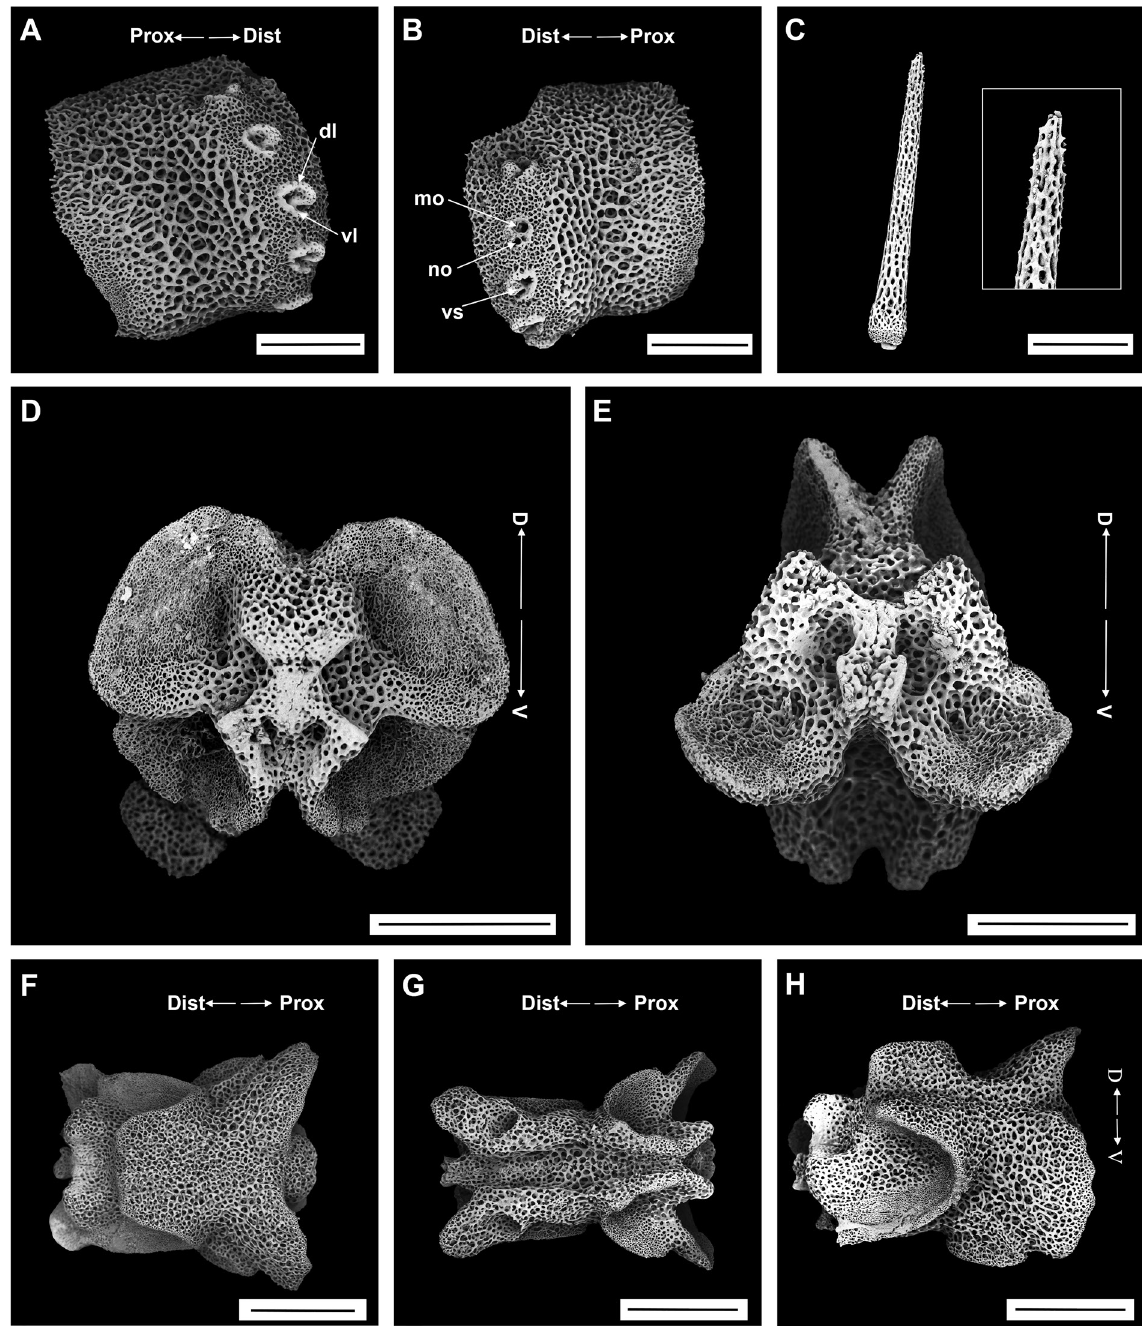
Fig. 28. Ophiacantha bathybia H.L. Clark, 1911, SEM (IDSSE EEB-SW0025). A–B . Lateral arm plate. C . Ventral arm spine. D–H . Vertebrae. D . Proximal view. E . Distal view. F . Dorsal view. G . Ventral view. H . Lateral view. Abbreviations: D = dorsal; Dist = distal; dl = dorsal lobe; mo = muscle opening; no = nerve opening; Prox = proximal; V = ventral; vl = ventral lobe; vs = volute-shaped. Scale bars: A–D, F–H = 500 µm; E = 300